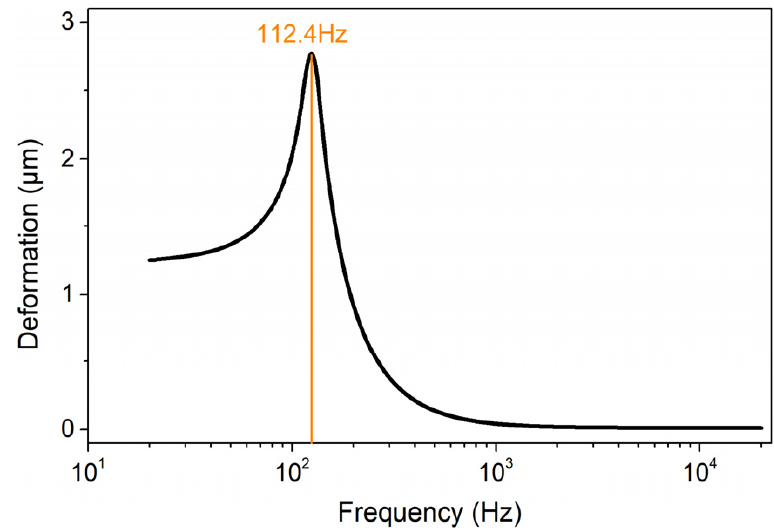
Figure 5. Diaphragm deformation diagram under different frequency acoustic waves when the pressure is 1 Pa.